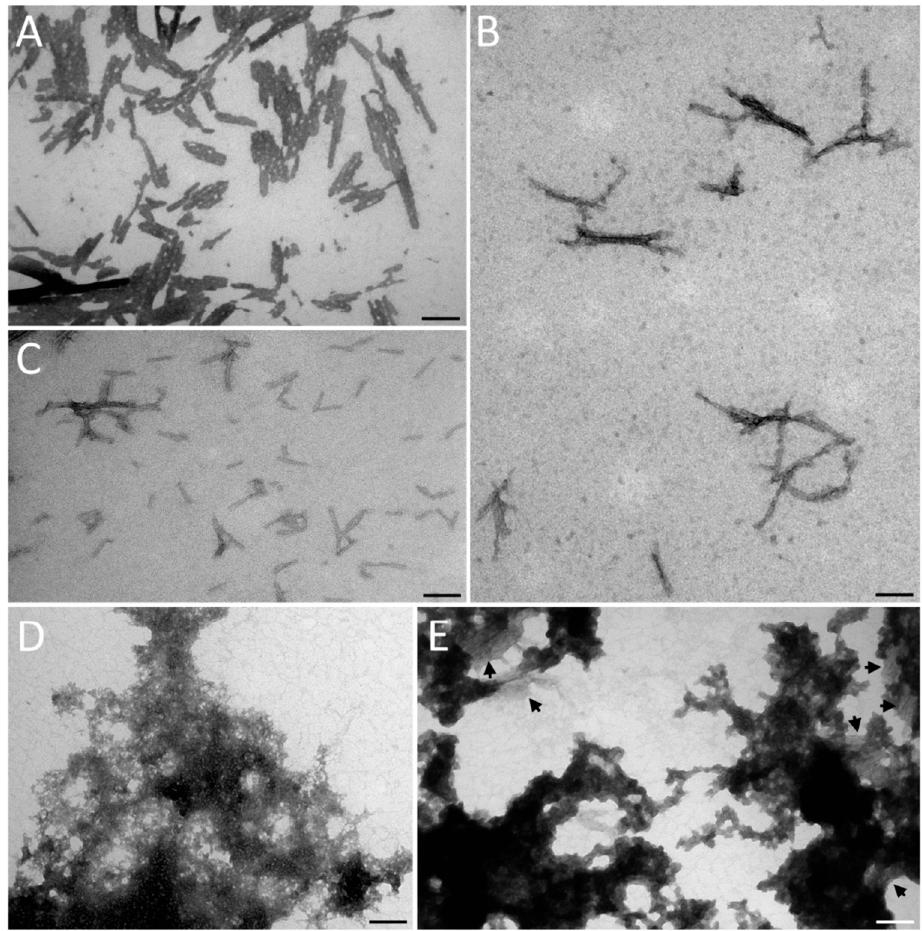
Figure 4. Electron micrographs of amyloid fibrils of free alpha-synuclein ( A ) and particles formed after 1.5-days of incubation of alpha-synuclein with 5 mM PAS ( B ), PSS ( C ), PEVP ( D ) and PEVP-50% ( E ). Black arrows in (E) show amyloid fibrils. Scale bar is 100 nm in all panels.